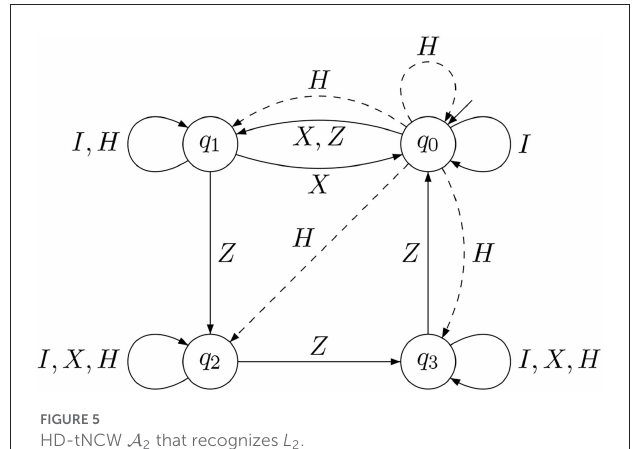
FIGURE5 HD-tNCW A 2 that recognizes L 2